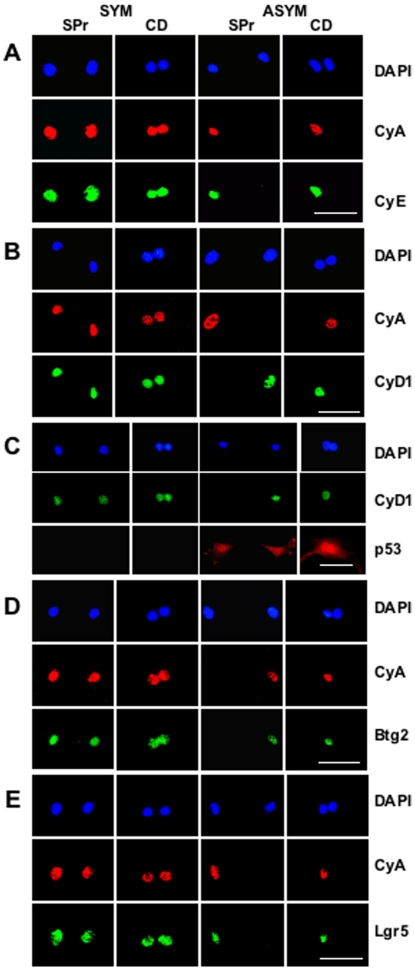
Evaluation of ASRA protein biomarkers by sister pair (SPr) and cytochalasin D (CD) assay.Shown are examples of fluorescent photomicrographs from parallel SPr and CD analyses using dual indirect ISIF performed simultaneously with two different biomarker-specific antibodies of different species origin. Species-specific secondary antibodies conjugated to red and green fluorochromes were used, respectively, for biomarker-specific imaging. SYM, symmetric self-renewal by p53-null Con-3 cells with ZnCl2. ASYM, asymmetric self-renewal by p53-inducible Ind-8 cells with ZnCl2 to induce p53 expression. DAPI, nuclear DNA fluorescence. CyA, indirect ISIF with specific antibodies for cyclin A, an indicator for cycling late G1, S, and G2 cells with greatest expression in G2 phase. A. Dual indirect ISIF with antibodies for cyclin A and cyclin E (CyE), an indicator for cycling late G1 and S phase cells, with highest expression in early S phase. B. Dual indirect ISIF with antibodies for cyclin A and cyclin D1 (CyD1), an indicator for cycling G1 or arrested late G1 and early S phase cells, with highest expression in late G1 phase. C. Dual indirect ISIF with antibodies for cyclin D1 and p53. D. Dual indirect ISIF with antibodies for cyclin A and Btg2. E. Dual indirect ISIF with antibodies for cyclin A and Lgr5. See Table 1 for quantitative analyses for the CyA∶CyD1 and CyA∶Btg2 SPr and CD assays. Only the CD analysis was quantified for the CyA∶Lgr5 assays (n = 61, 58; and % co-asymmetric CyA and Lgr5 expression = 20%, 4% for paired nuclei in the ASYM state versus the SYM state, respectively; p<0.006 by the two-tailed Fisher's exact test). Scale bars = 50 microns.